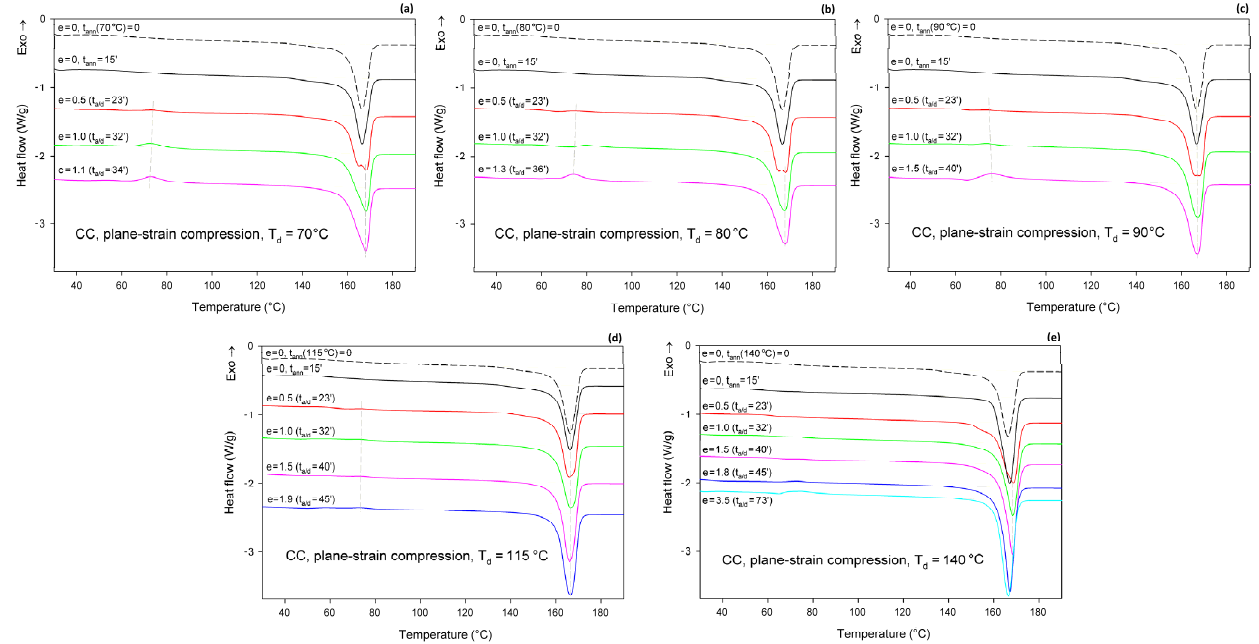
Figure 8. DSC heating scans of semicrystalline CC samples deformed in plane-strain compression at T d = 70 ◦ C ( a ); 80 ◦ C ( b ); 90 ◦ C ( c ); 115 ◦ C ( d ); and 140 ◦ C ( e ) to the true strain indicated. The dashed line shows the thermogram of the initial CC sample, cold crystallized at T = 122 ◦ C and not processed further. The total residence time at the deformation temperature, t a/d , is indicated for each curve.